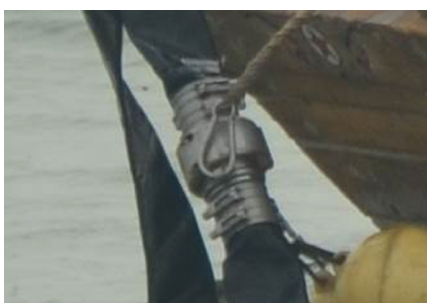
Figure 44: Joint morphology after the